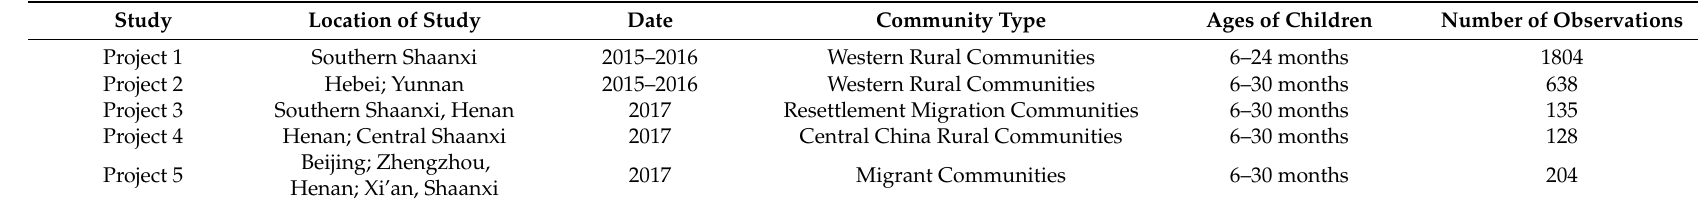
Table 1. Summary of Project 1 to Project